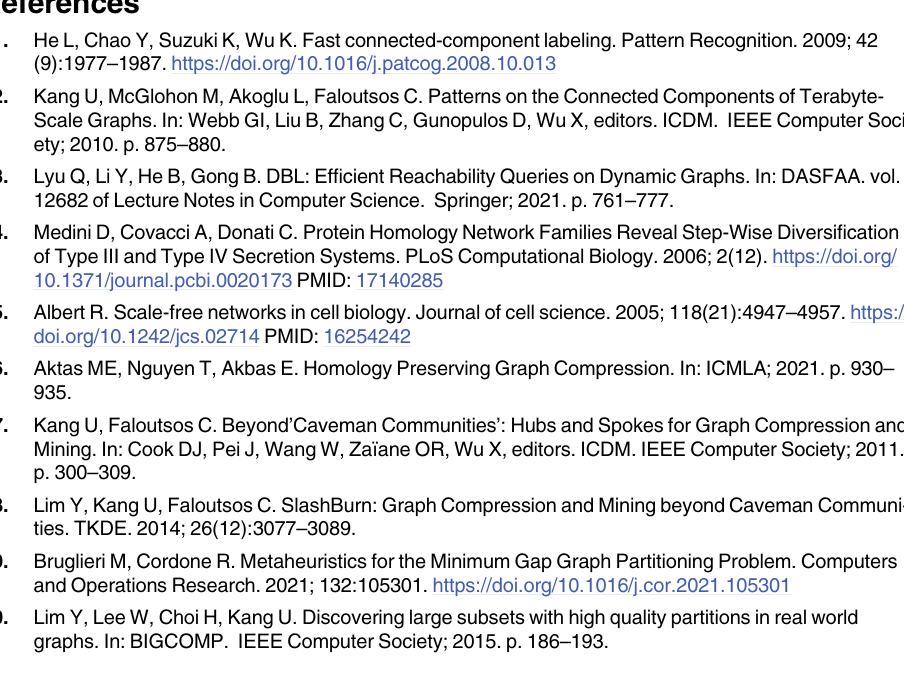
Con ensures that the memory consumption of each worker is O ((| V | + | E |)/ ρ ) where ρ is the number of partitions and improves performance by 22.7% over when using a typical hash table. As a result, on a commodity cluster, UniCon handles up to 4096 times larger graphs than graphs competitors can process. With a cluster of only 10 cheap machines, UniCon suc- ceeds in processing a graph containing 129 billion edges, showing the fastest